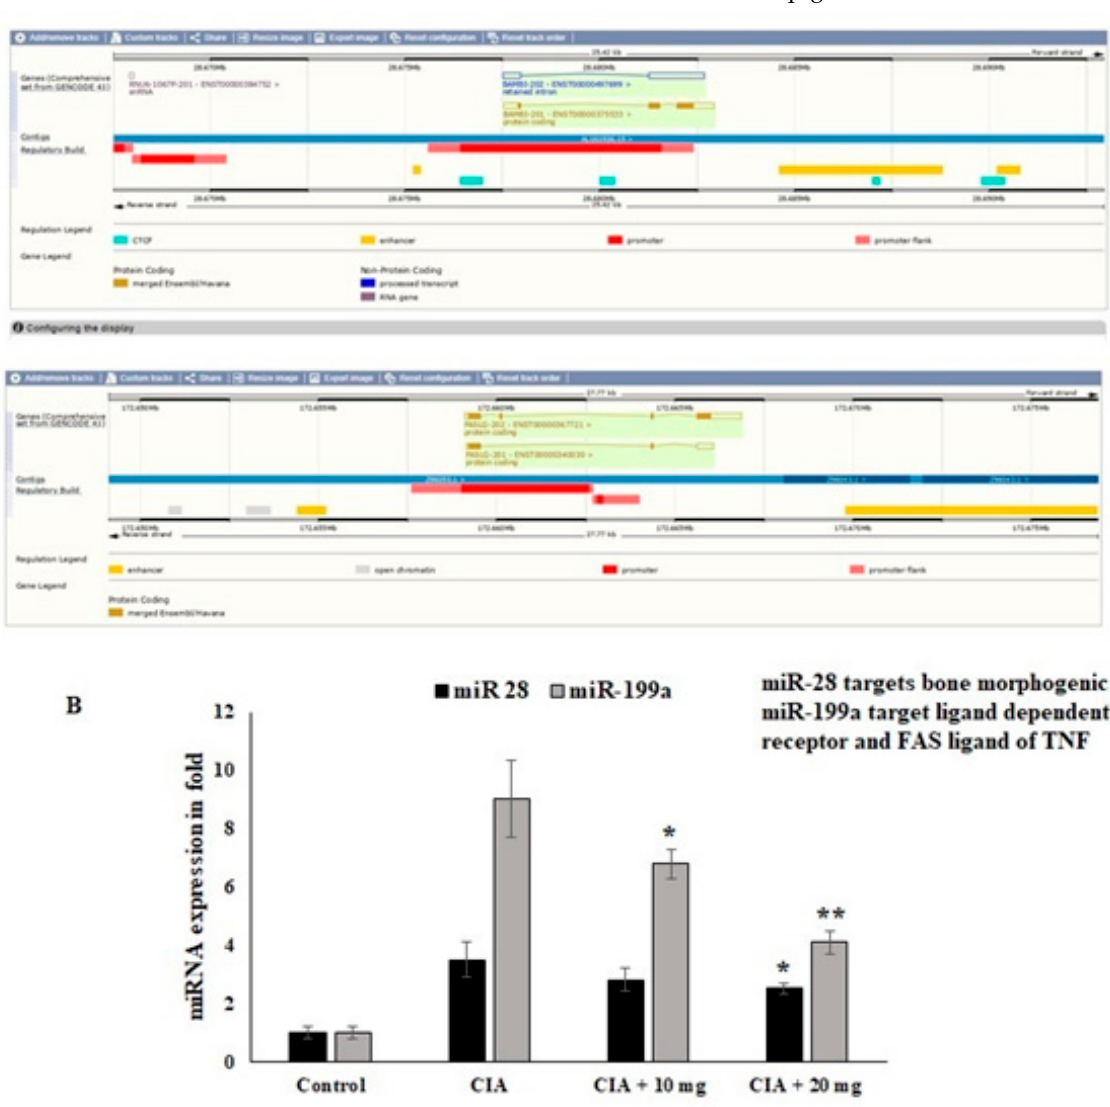
Figure 7. Effects of OL -EAE extract on mRNA-targeted miRNA expression levels in paw limb tissues: miR-28 and miR199a are the targets of NF-kB and COX-2. ( A ) The miRNAs abrogate the autoimmune inflammatory conditions in osteo sites. ( B ) The expression levels of mRNA coding targets such as miR-28 and miR-199a were compared with U6 internal control CIA, low-dose CIA/ OL- EAE, and high-dose CIA/ OL- EAE groups. Each value is expressed in triplicate as the mean ± SD; * p < 0.05 and ** p < 0.001 when comparing the CIA disease group with the CIA OL- EAE-treated group ( n = 5).